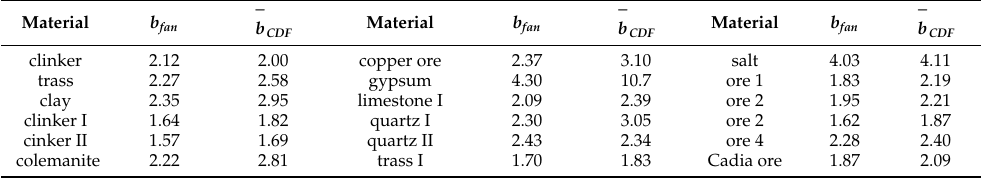
Table 4. Comparison of b -values from CDF fitting with Swebrec function and fan fitting.